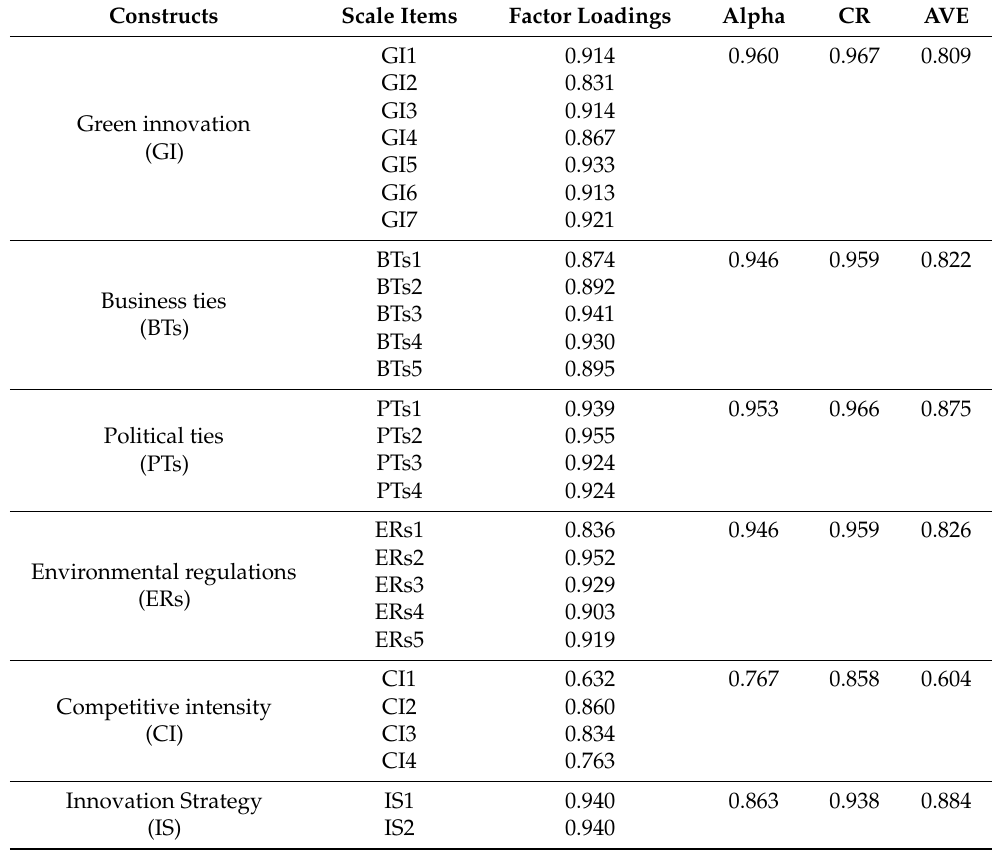
Table 1. Construct reliability and